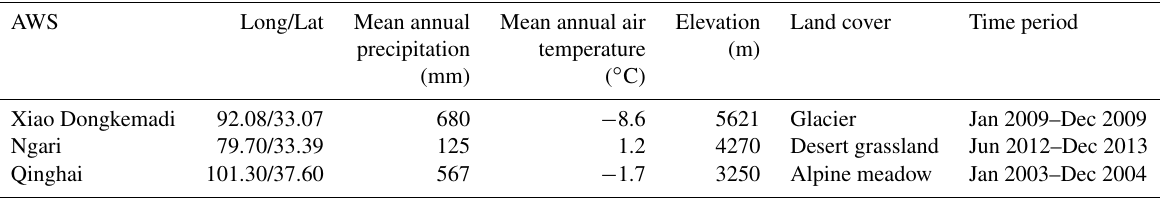
Table 1. Summary of the AWS sites. AWS Long/Lat Mean annual Mean annual air Elevation Land cover Time period precipitation temperature (m) (mm) ( ◦ C) Xiao Dongkemadi 92.08/33.07 680 − 8.6 5621 Glacier Ngari 79.70/33.39 125 Desert